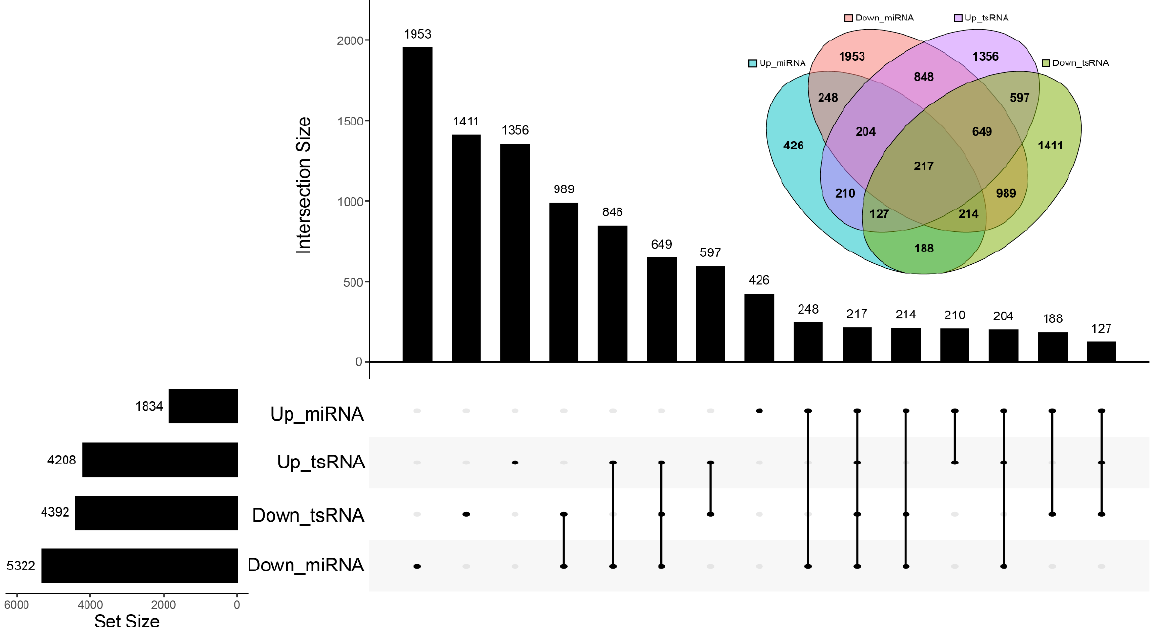
Figure 5. The number of predicted target genes for differentially expressed miRNAs and tsRNAs. On the left, the number of independent target genes is indicated. The middle part represents the intersection of the four sets of data. The Venn diagram summarizes the number of shared predicted genes of the four groups.